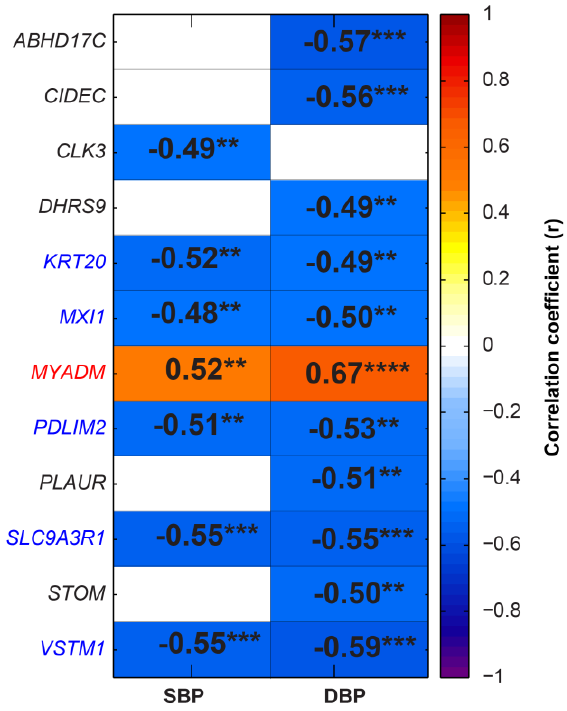
Figure 4. Correlation analysis between blood pressure and expression of the DEGs in REF (n = 19) and HBP subjects (n = 16). Pixel map representation of the correlation between blood pressure and expression of the DEGs in REF and HBP subjects. Positive r indicates the positive correlation and negative r indicates the negative correlation. (** p < 0.01, *** p < 0.001 and **** p < 0.0001, cutoff value |r| is 0.48).